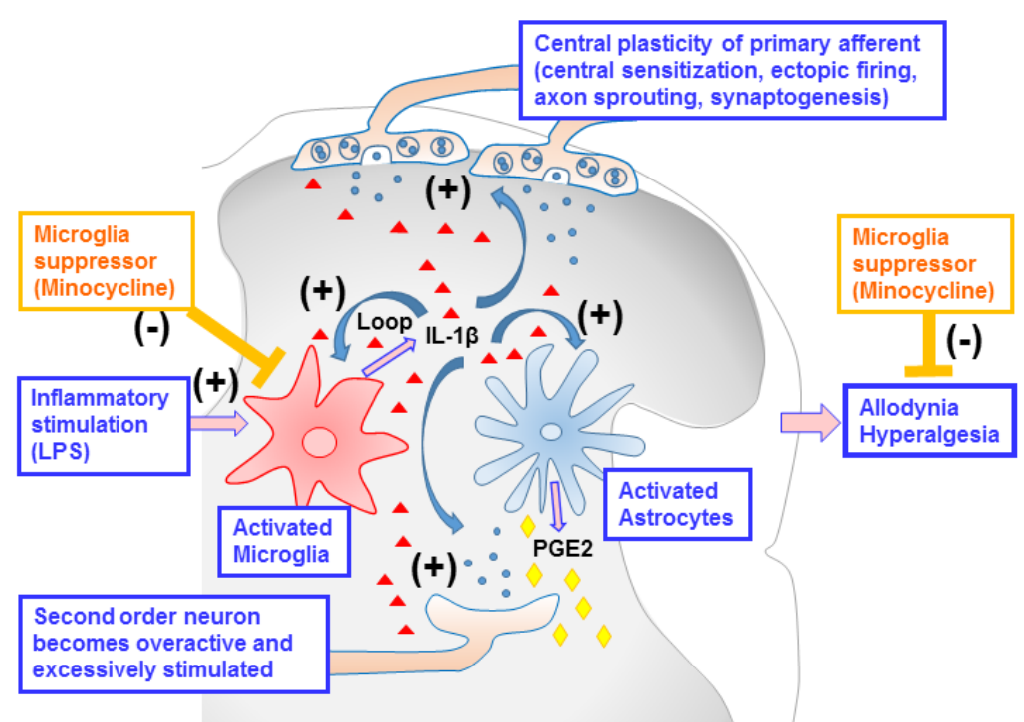
Figure 7. Schematic illustration of glia–glia and neuron–glia interaction in the spinal cord dorsal horn in neonatal systemic inflammation-induced pain hypersensitivity. Systemic LPS exposure led to spinal cord inflammation, including increased microglia and astrocyte activation, microglia-related pro-inflammatory cytokine interleukin-1 β (IL-1 β ), and pain mediator prostaglandin E2 (PGE2), which induced a positive feedback loop. The above effects may cause primary afferent neurons to undergo central plasticity (central sensitization, ectopic firing, axon sprouting, synaptogenesis), and second-order neurons to become overactive and excessively stimulated in the spinal cord dorsal horn, which enlarges the effect of original insults on nociception and results in the enhancement of pain sensitivity (allodynia and hyperalgesia) in neonatal rats. These compromises in both gliosis and behaviors are attenuated by minocycline (a microglia suppressor), suggesting that microglia activation plays a critical role in mediating these pathological changes.